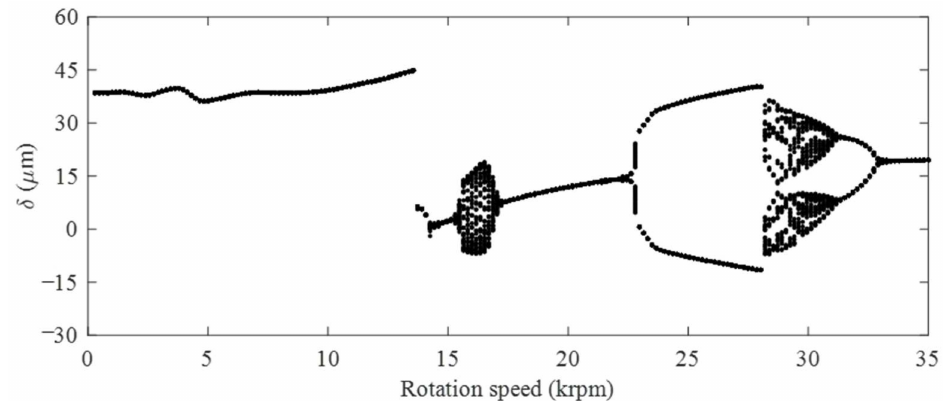
Figure 8. The bifurcation behavior of the gear transmission with a clearance of 0.6 mm.